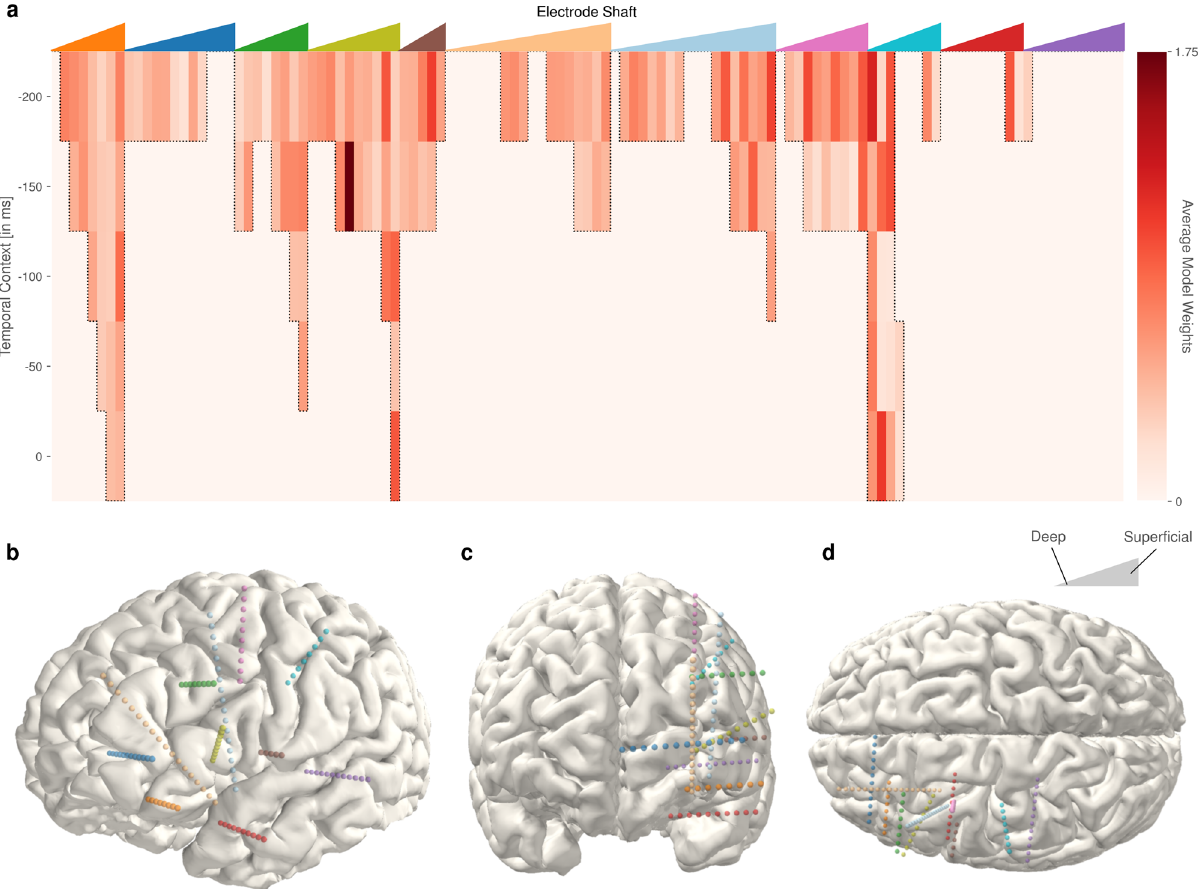
Fig. 5 Anatomical and temporal contributions. a Spatiotemporal decoder activations averaged across 9 classes and 40 frequency bins. The colored triangles at the top of the panel correspond to the colored electrode shafts in ( b – d ). The left edge of each triangle represents the deepest contact of a respective colored electrode shaft and the most super fi cial contact the same shaft is represented at the right edge, with the intermediate contacts ordered longitudinally in between. The activations (i.e., transformed average model weights) for the decoding models at each electrode and temporal lag are indicated by the vertical bars below the corresponding colored triangle. Darker red indicates higher absolute activations. The activations indicate that inferior frontal and middle frontal cortices are predominately employed in decoding. b – d Different views of electrode locations for the participant: b left lateral, c frontal, d